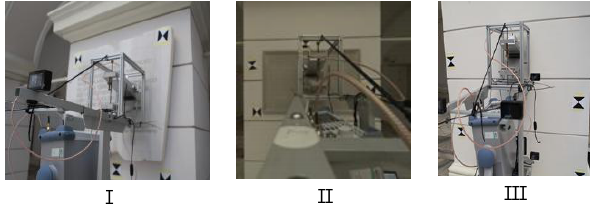
Figure 1. Experimental setup for the remote microwave sensor.